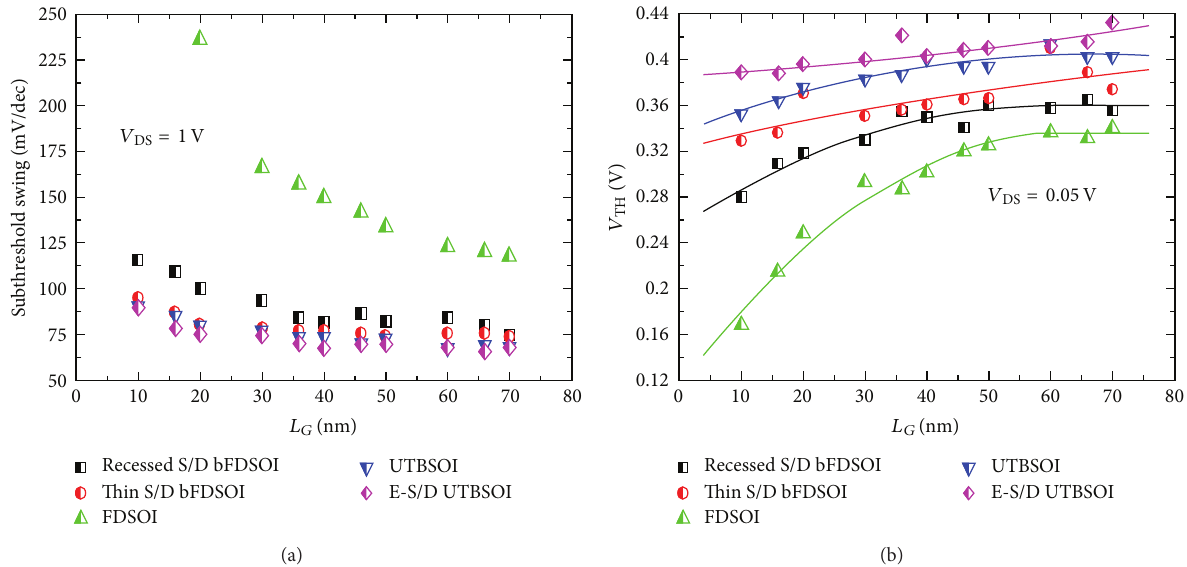
Figure 8: Simulated (a) subthreshold swing and (b) 𝑉 dependence on the gate length 𝐿 𝐺 . The bFDSOI-FETs show improved subthreshold TH rolloff than FDSOI-FET, similar to the UTBSOI-FET. swing and better 𝑉 TH